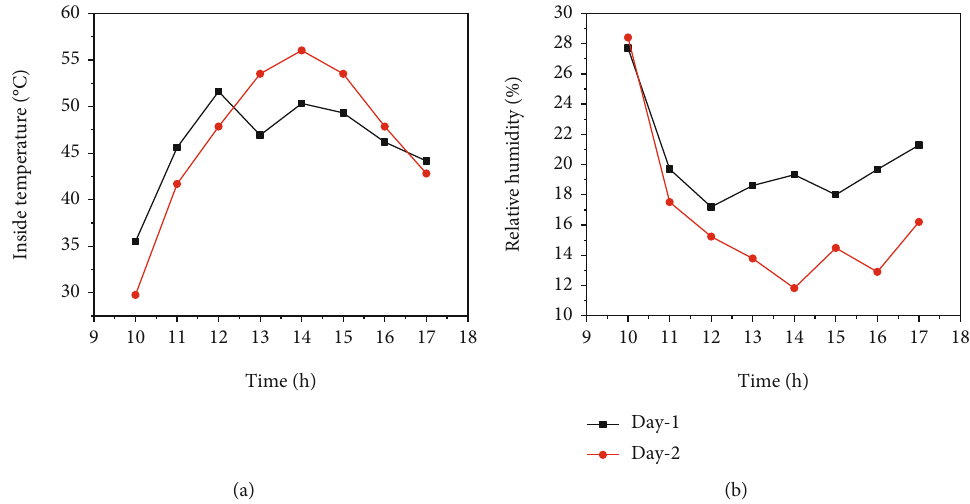
Figure 5: Variation of air inside (a) temperature and (b) relative humidity with time of day-1 and day-2.